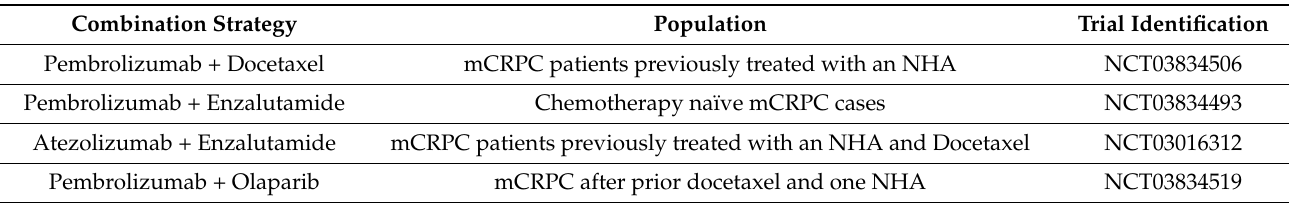
Table 5. Ongoing phase III trials of ICI in combination with other